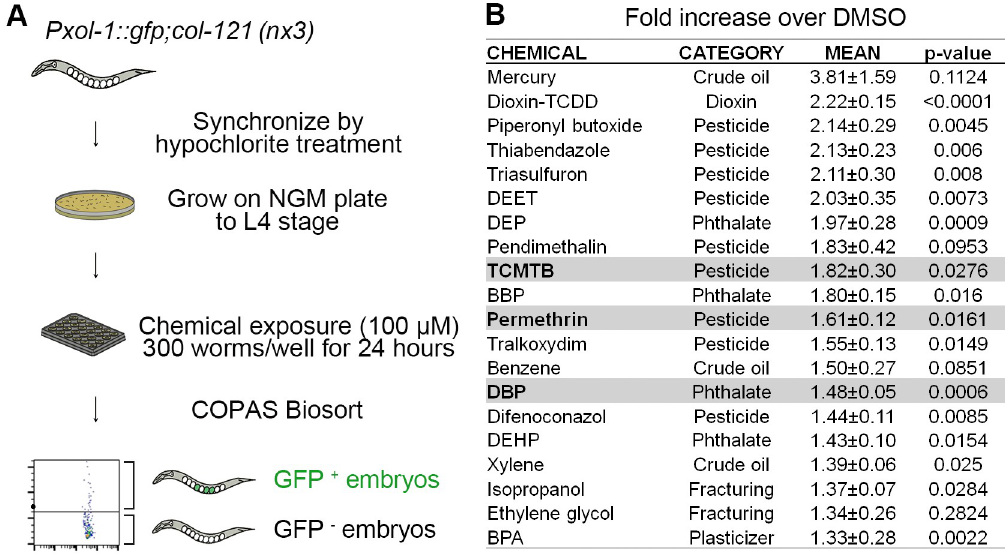
Fig 1. Flowchart for high-throughput screening strategy and readout. (A) Worms carrying a collagen gene mutation ( col- 121(nx3) ) for increased cuticle permeability and a male-specific promoter driving GFP expression in embryos ( Pxol-1 :: gfp) , were synchronized by hypochlorite treatment. Age-matched L1 stage animals were grown on plates (6,000 per 100 mm plate) until reaching the L4 stage. L4 stage animals were dispensed into 24-well plates (300 worms/well) with each well containing OP50 E . coli (OD600 = 24) in M9 buffer and a single chemical from our library ( � 100 μ M each) followed by a 24-hour incubation at 20˚C. After thoroughly washed in M9, young adult animals were sorted based on fluorescence intensity with the COPAS Biosort. Adult worms with GFP + embryos are detected as distinct from worms carrying GFP - embryos and debris, which are below the threshold (black horizontal line). Threshold was determined by comparing levels of GFP + embryos detected in two genetic mutants, Pxol-1 :: gfp and Pxol-1 :: gfp;him-8 . More than 5,000 animals were assessed in biological triplicates for each chemical exposure. (B) Readouts obtained with the COPAS Biosort for the chemicals that showed higher fold increase in GFP + embryos compared to DMSO than BPA, a known endocrine disruptor (mean ± SEM; p -values calculated by the paired two-tailed t -test, 95% C.I.). The three chemicals highlighted in gray, TCTMB, permethrin, and DBP, were assessed further for their effects on germline